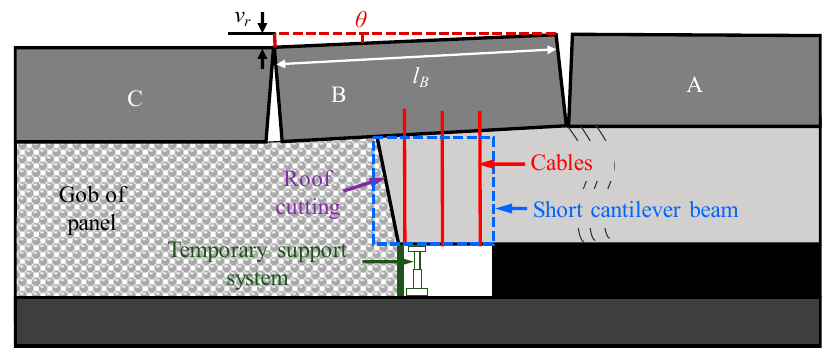
Figure 2. Schematic diagram of the entry surrounding structure.